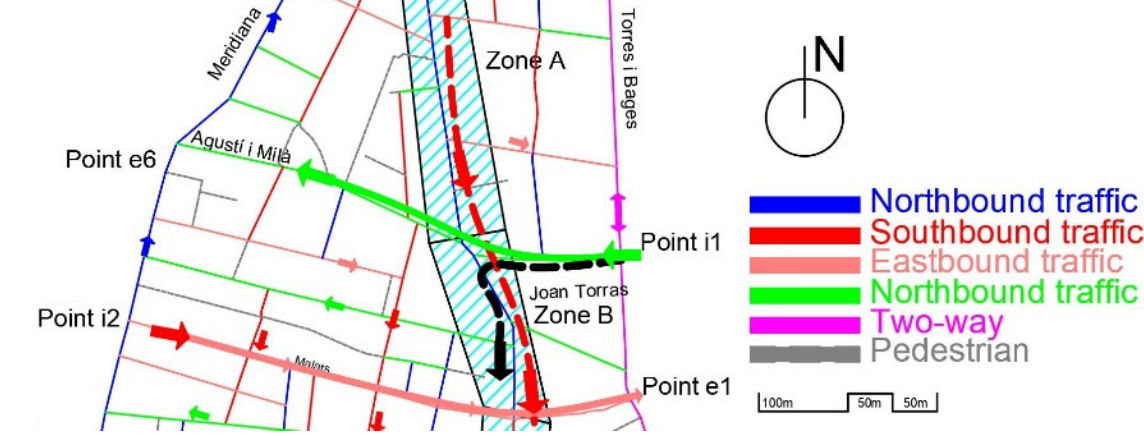
Figure 4. Initial street configuration before the pacification.